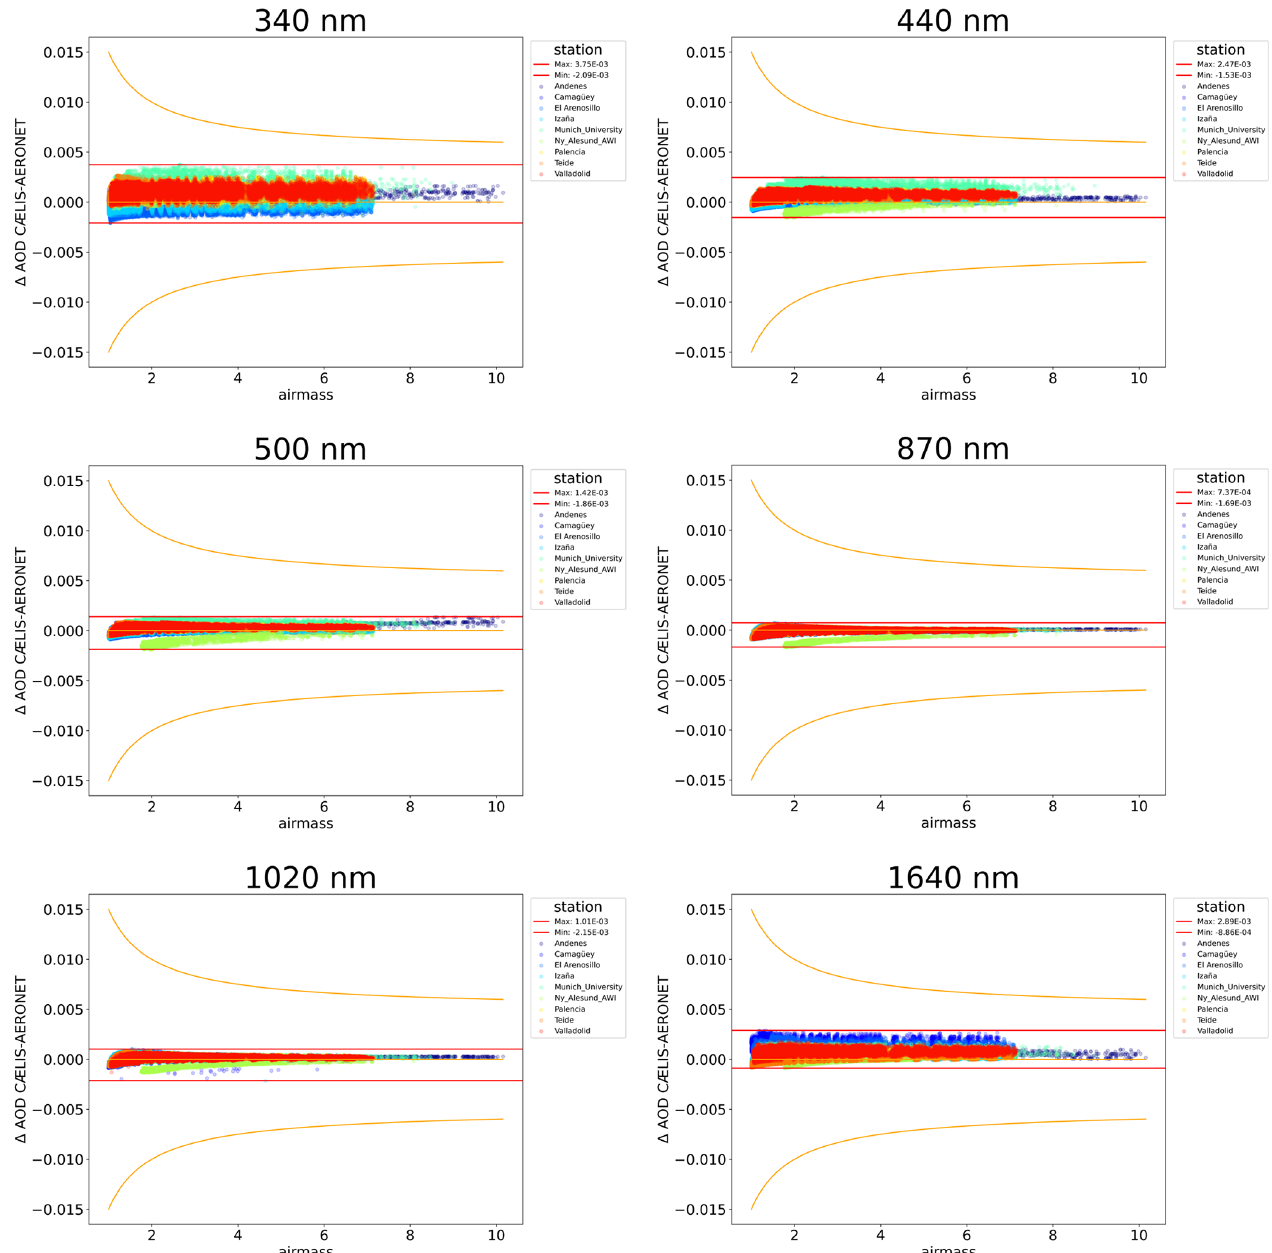
Figure 7. Differences in AOD (AERONET–CÆLIS) as a function of air mass for several channels. The red lines indicate the maximum and minimum of the differences. The orange lines indicate the boundaries of the U95 criterion of the WMO (2005)